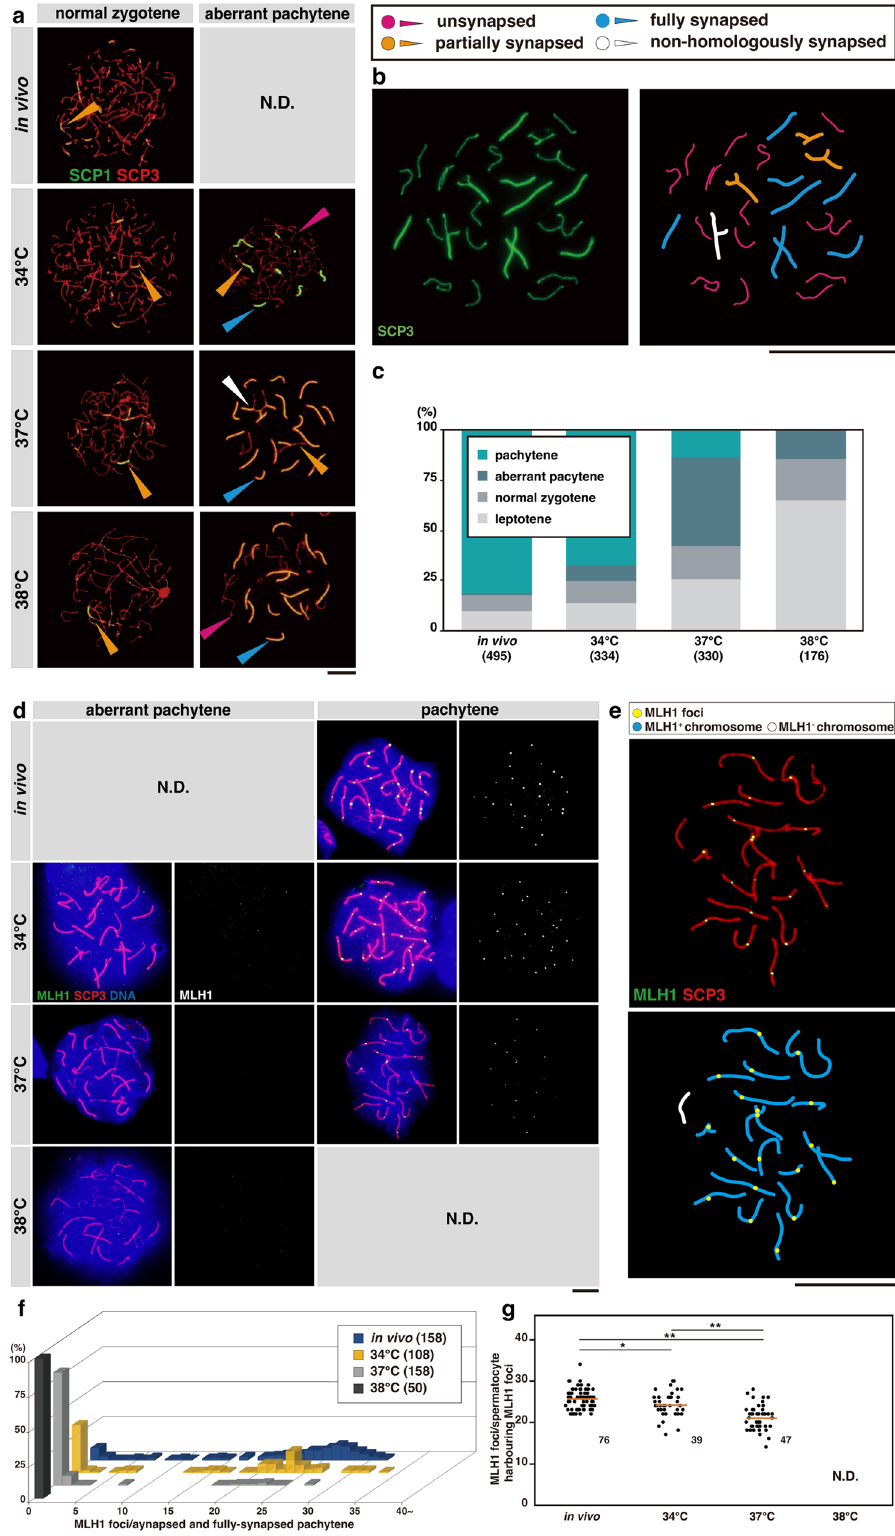
Figure 8 summarizes the temperature-dependent meiosis fail- ure and the role of meiotic checkpoints that we propose. At 34